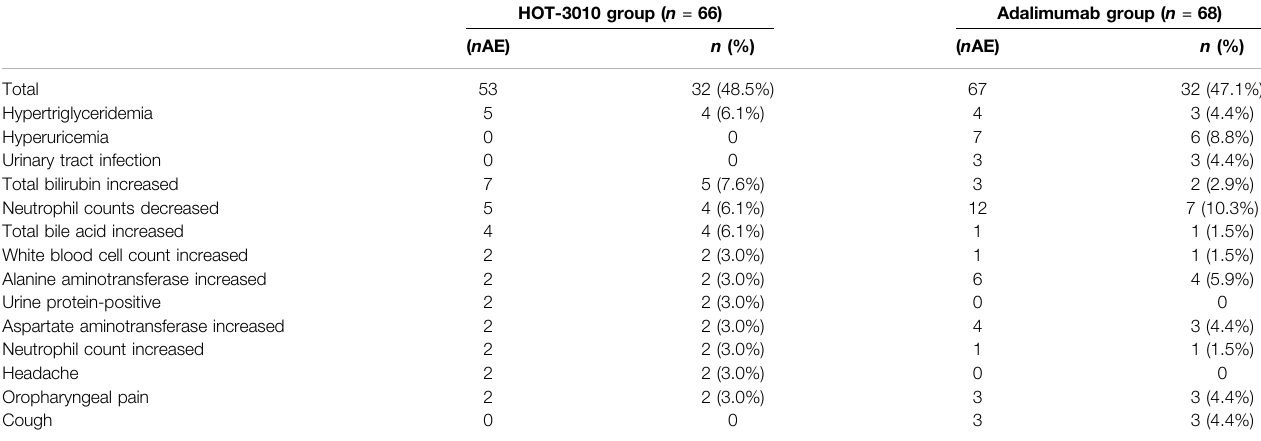
TABLE 4 | Treatment-emergent adverse drug reaction (number of events, the number (%) of subjects, more than 3%). HOT-3010 group ( n =